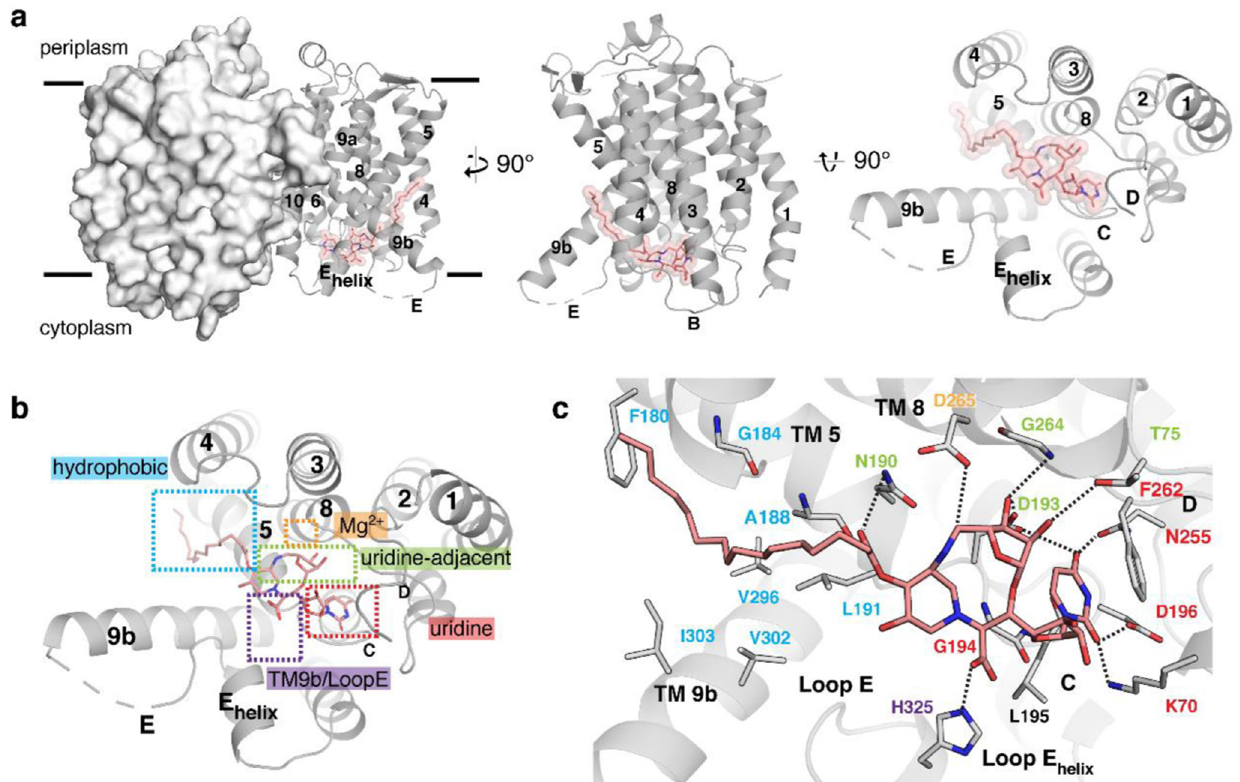
Fig. 5 | X-ray crystal structure of MraY AA bound to SPM-1. a , left: The MraY AA - SPM-1complexstructureasviewedfromthemembrane,withoneprotomershown in surface representation and one in the cartoon. SPM-1 is shown in salmon. For simplicity, one protomer of MraY AA with bound SPM-1 is shown from the mem- brane (center) and cytoplasmic views (right). b The binding sites recognized by SPM-1 (salmon) on the cytoplasmic side of MraY AA include the uridine (red),